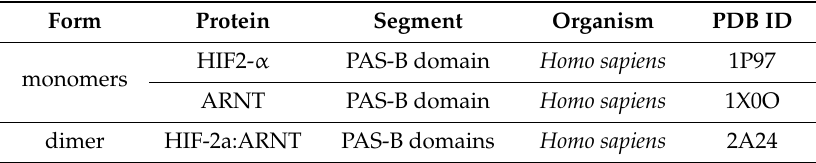
Table 2. bHLH–PAS protein structures deposited in the PDB obtained with NMR.